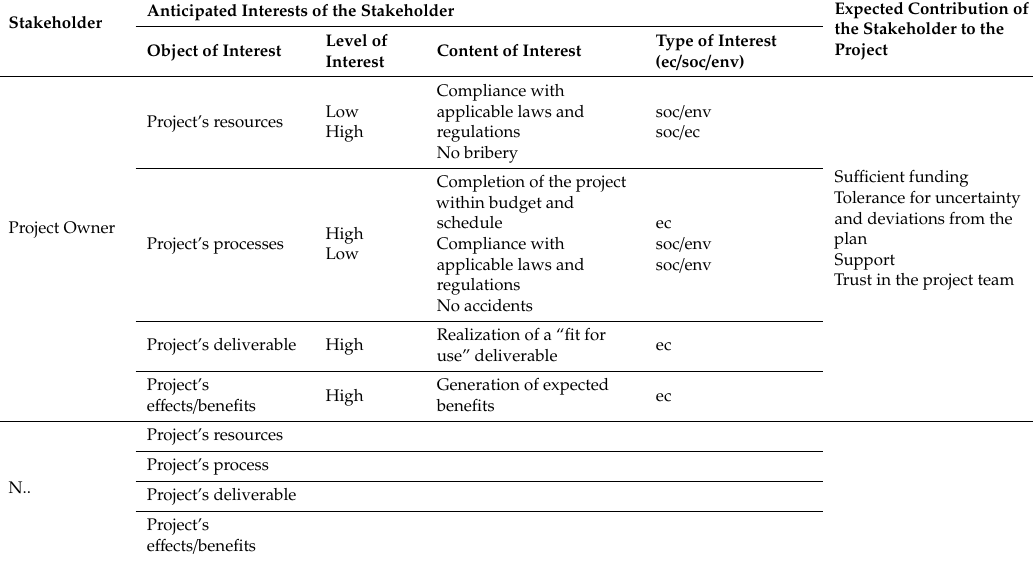
Table 6. Proposed framework for analysing stakeholder’s interests (with fictitious interests of a project owner stakeholder filled in as